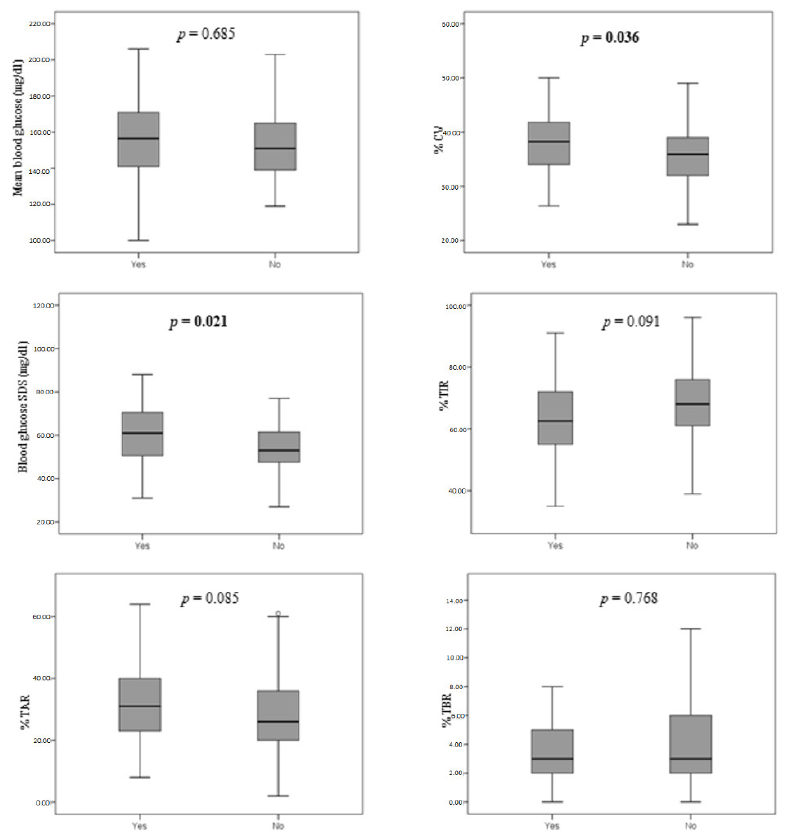
Figure 1. Boxplots illustrating the comparison of CGM data among patients according to the presence of lipodystrophy.